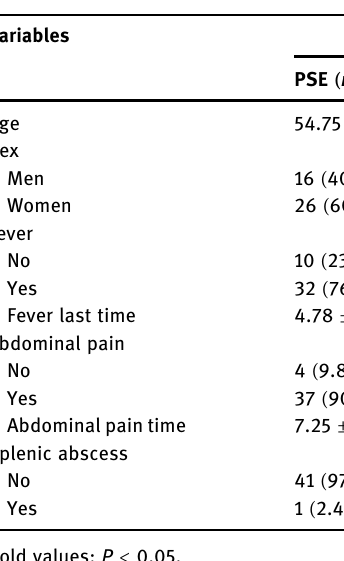
Table 1: Clinical features of PSE and